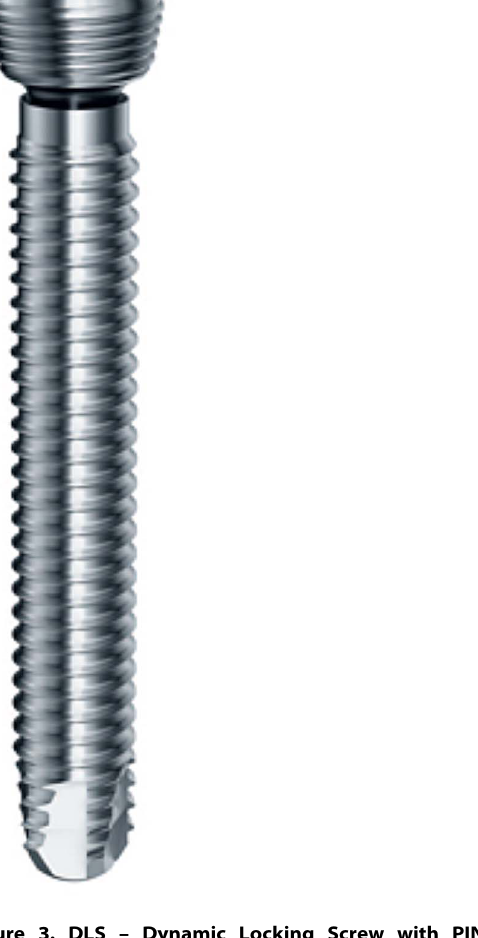
Figure 3. DLS – Dynamic Locking Screw with PIN-Sleeve-